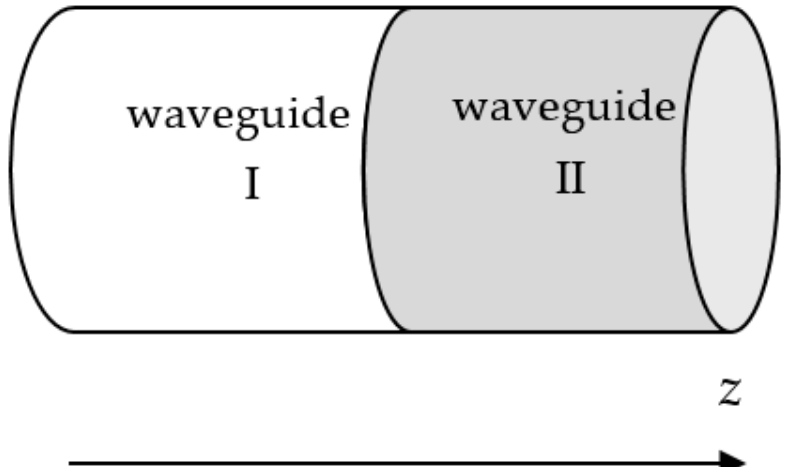
Figure 2. A junction between two cylindrical waveguides filled with two different media with the same cross-sections.